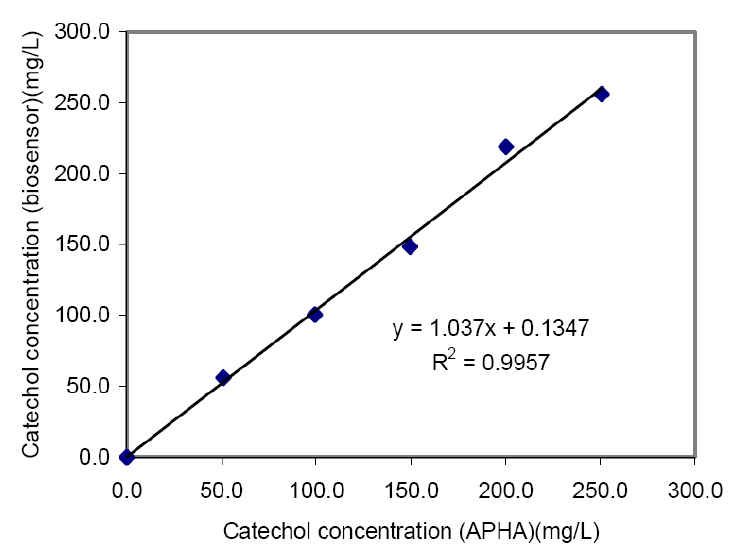
Figure 12. Relationship between an optical laccase biosensor with APHA method in the detection of